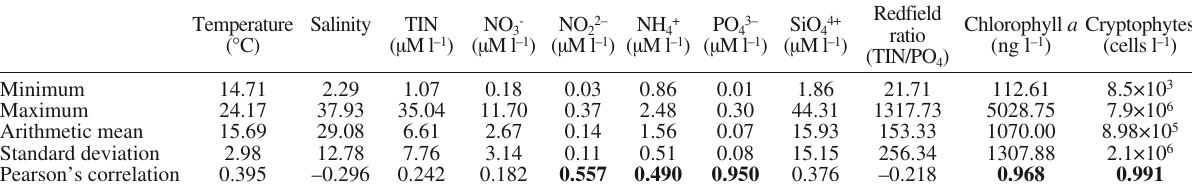
Table 1. – Descriptive statistics of physicochemical parameters and cryptophyte abundance. Pearson’s correlation of alloxanthine concentra- tion with the physicochemical parameters is highlighted in bold when values are statistically significant